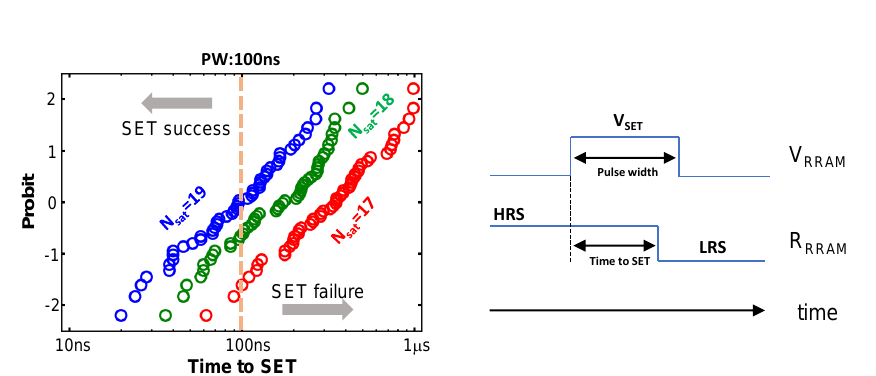
Figure 16: Simulated time of the SET transition time starting from different N sat values and the relation to SET failure with a given pulse-width. The relation between the pulse- width and time-to-set is illustrated in the righthand-side. A set-failure can be observed when the time-to-set is longer than the